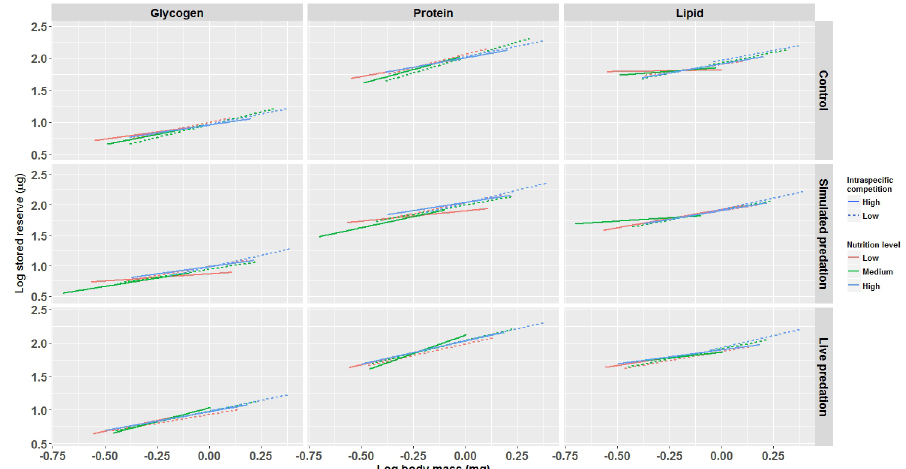
Fig 4. Stored teneral reserves in male mosquitoes. Predicted lines for log (stored teneral reserves–glycogen, protein and lipid) ~ log (adult body mass) for larval nutrition × intraspecific competition × predation treatments across replicate containers for male mosquitoes. All variables are log transformed. Data were statistically tested using a mixed model MANCOVA and significant effects are described in Table 3.